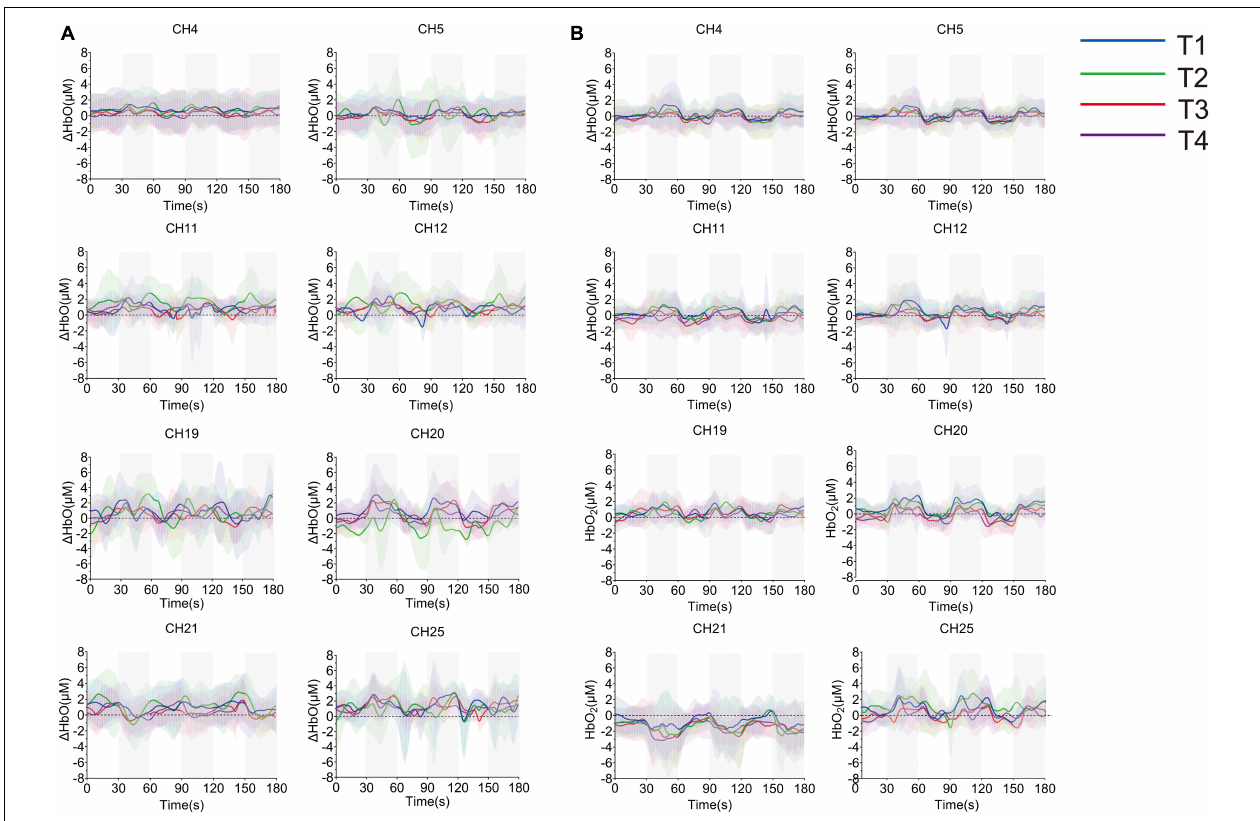
FIGURE 8 | Time series of oxyhemoglobin changes during the task. (A) Non-resistance movement; (B) resistance movement. The gray area is the stimulus period. The solid line in the figure represents the average value of concentration, and the upper and lower shaded parts represent the error (mean ± SD) ( n =